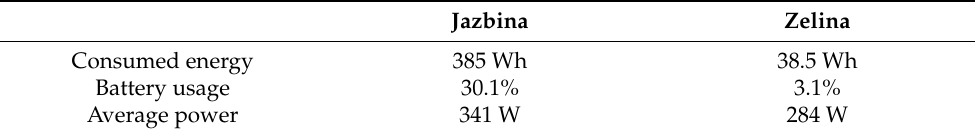
Table 6. Energy consumed during the experiments.